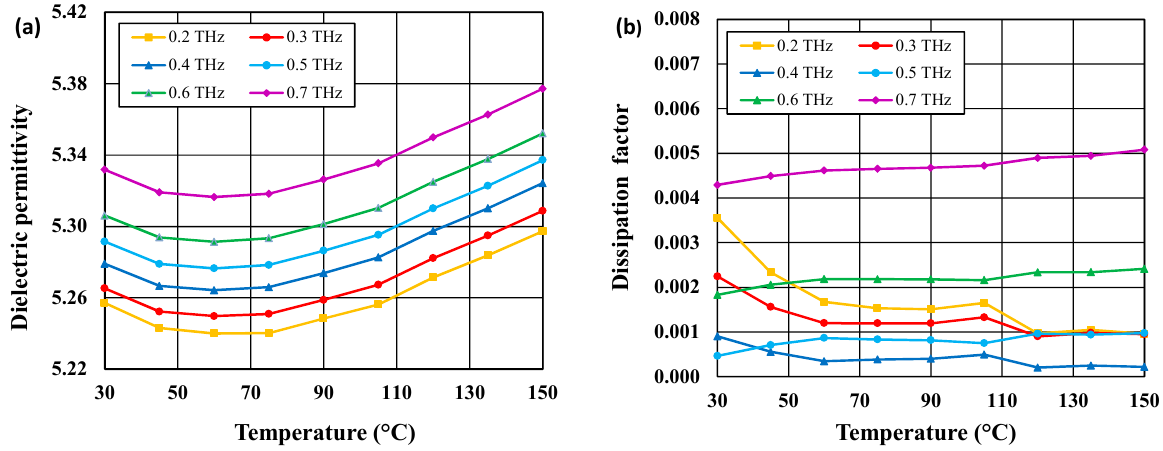
Figure 6. Comparison of dielectric permittivity ( a ) and dissipation factor ( b ) of CuB 2 O 4 ceramic sintered at 940 °C as a function of temperature in the range 30–150 °C for a few frequencies in the 0.2–0.7 THz range.